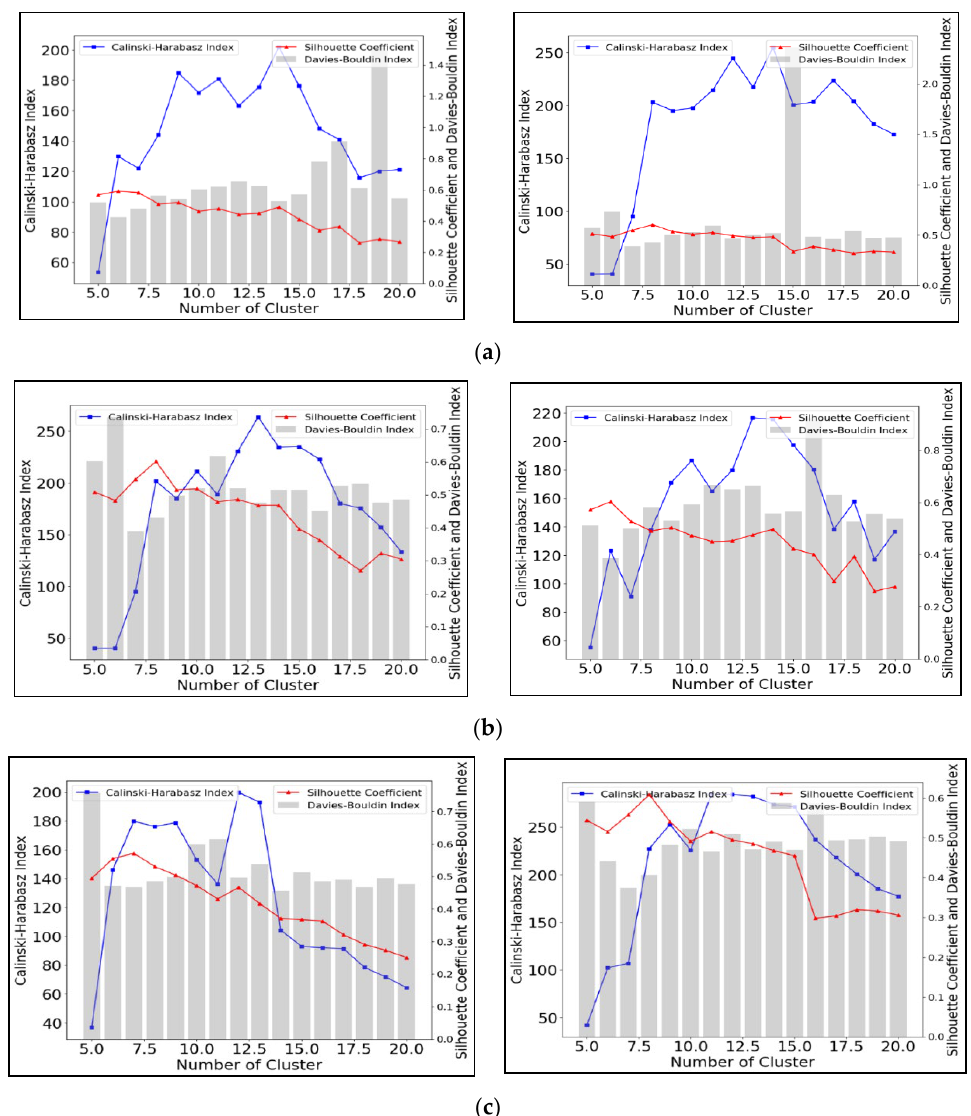
Figure 7. Performance evaluation for Spectral Clustering with different cluster numbers under synthetic rainfall scenarios including ( a ) 3-h (left 2-year and right 5-year), ( b ) 12-h (left 2-year and right 5-year), and ( c ) 48-h duration (left 2-year and right 5-year).